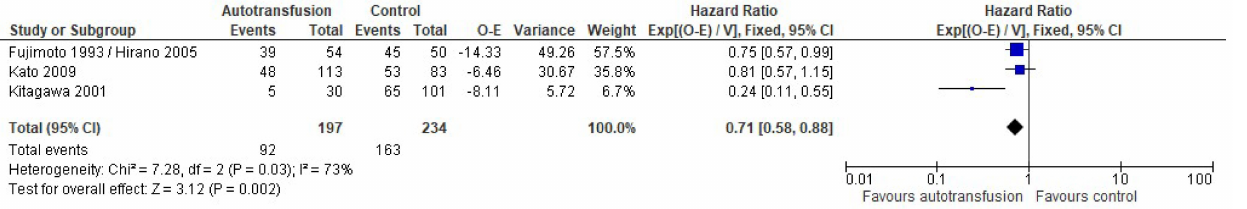
Figure 7. Forest plot for overall survival in hepatectomy patients with autotransfusion and without. Blue squares indicate individual effects and black diamond illustrates overall